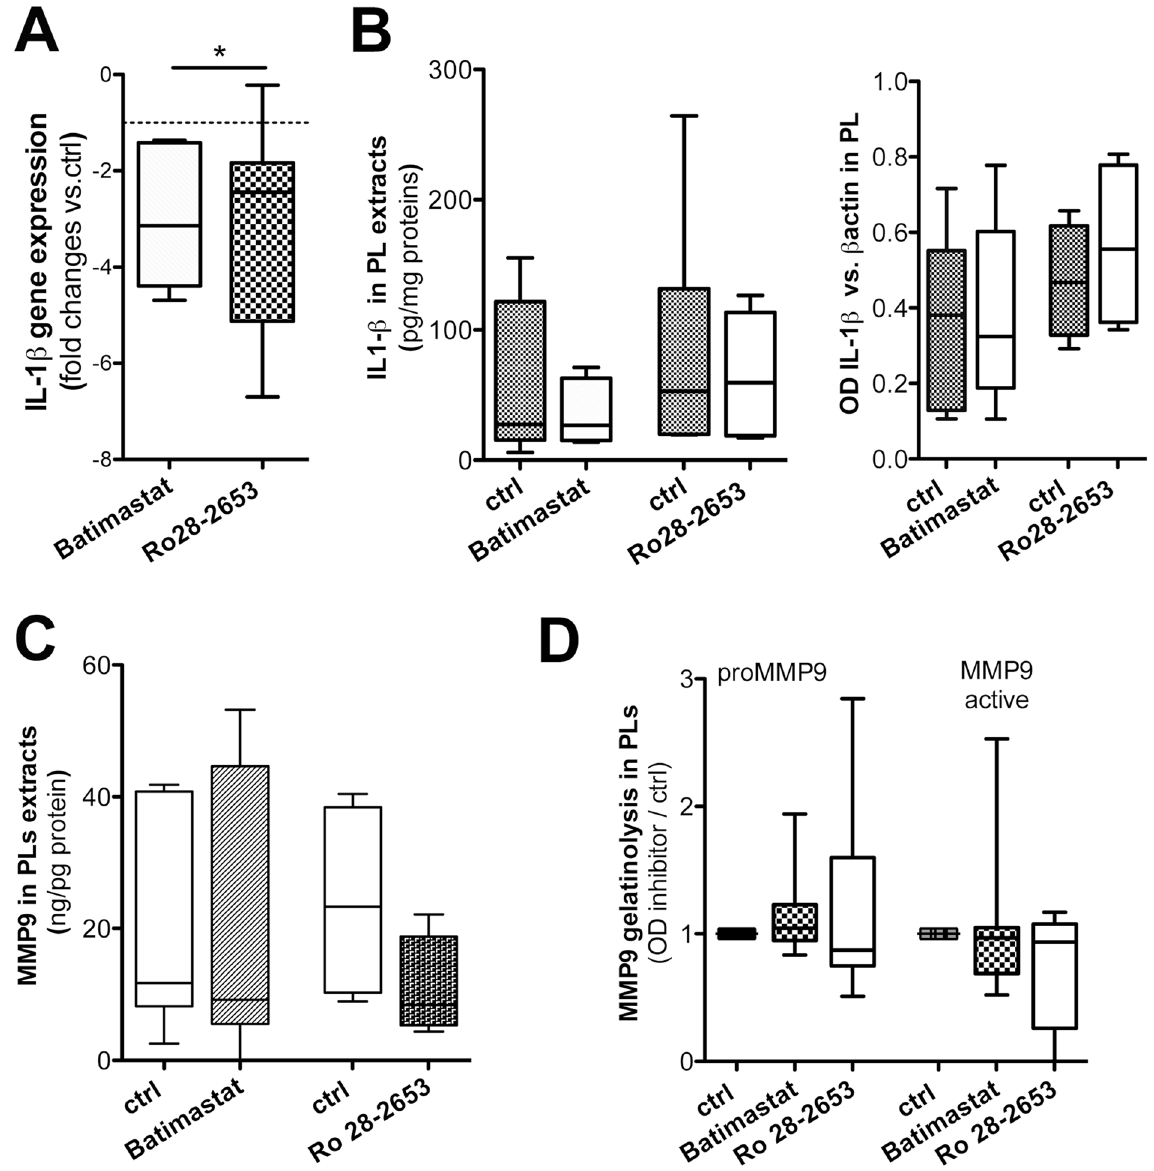
Figure 6. Ex-vivo vessel cultures: effect of MMPs antagonists. IL-1 β mRNA level changes upon PLs treatment either with Batimastat (n = 12) or Ro28-2653 (n = 13) are shown ( A ). Wilcoxon signed rank test is applied. IL-1 β amount in PL extracts ( B , left) and results from densitometry on proIL-1 β expression ( B , right) are displayed. MMP9 content ( C ) and MMP9–related gelatinolytic activity ( D ) in PL extracts are plotted. Values displayed as boxes are shown with whiskers 5–95 percentile. Significant difference is shown as * p <